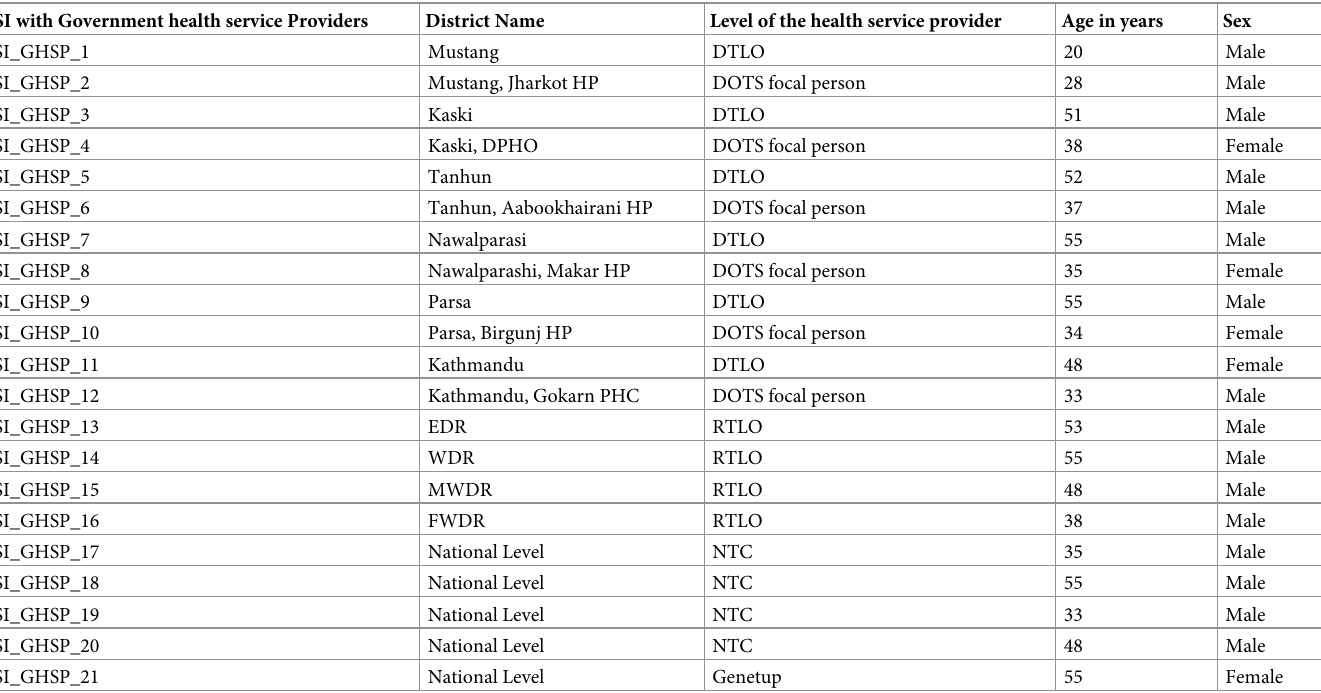
Table 2. Semi-structured interview with various level of government health service providers.